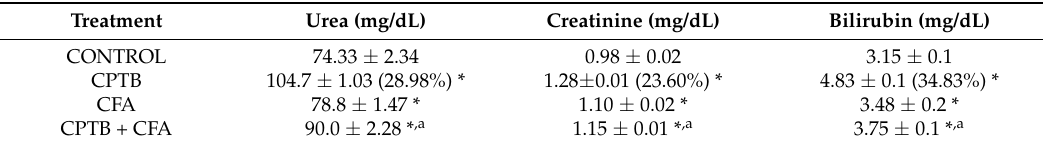
Table 3. Protective effects of caffeic acid on capecitabine-induced changes in the plasma levels of urea, creatinine and bilirubin in